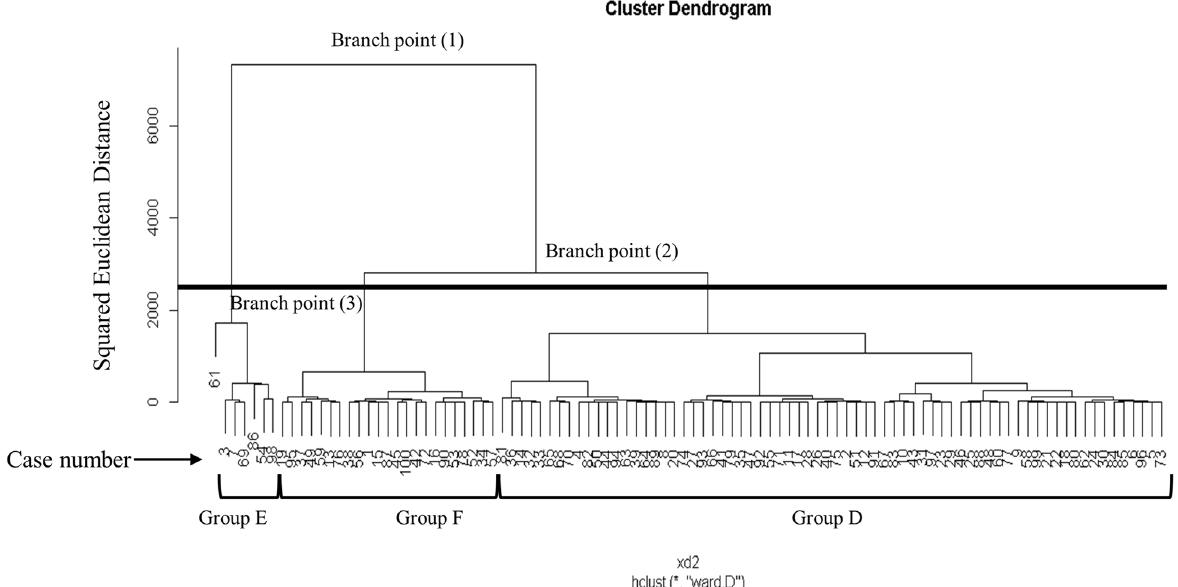
Fig. 4 Dendrogram from cluster analysis based on condylar position relative to the skull base position. Branch point (1): squared Euclidean